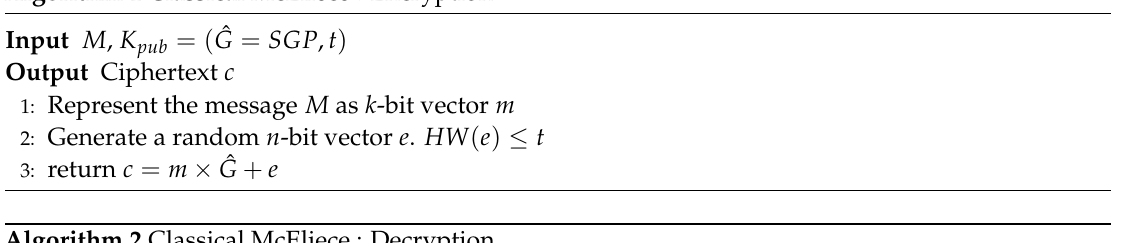
Algorithm 1 Classical McEliece :